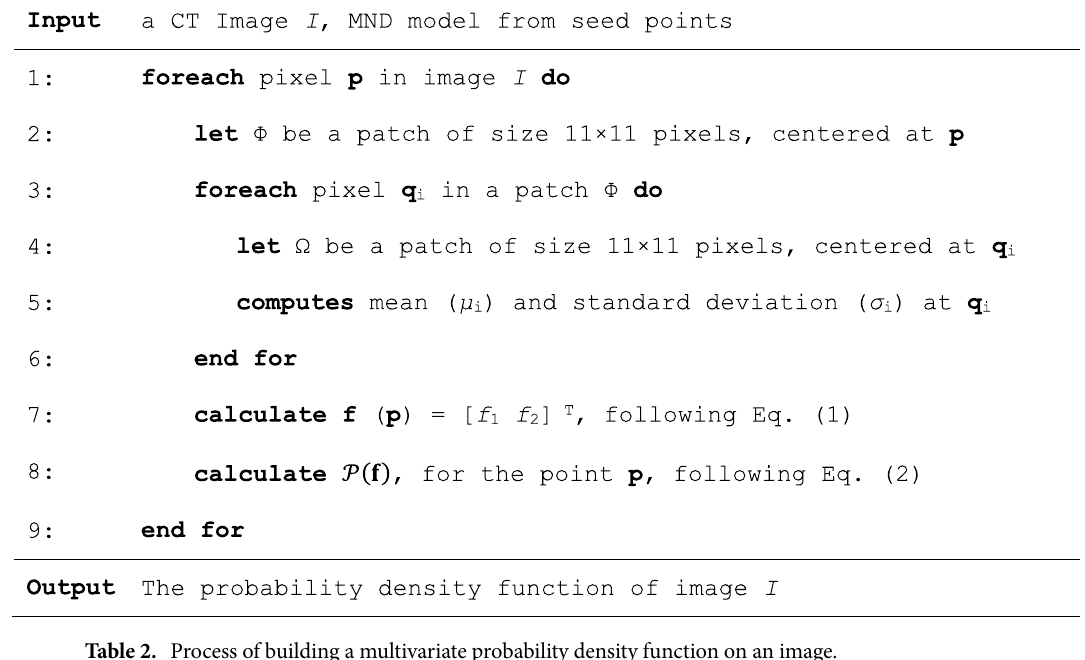
Table 2. Process of building a multivariate probability density function on an